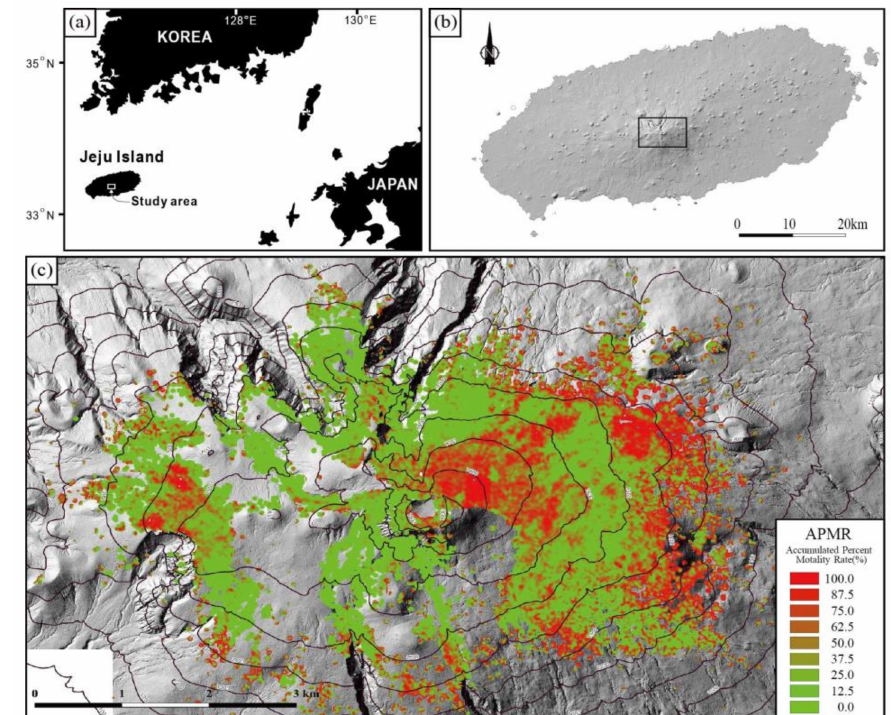
Figure 1. ( a , b ) Location of the study area, and ( c ) APMR (accumulated percent mortality rate, %) map of the Korean fir in the study area. APMR was analyzed for the area within a radius of 30 m around each mapped Korean fir tree by